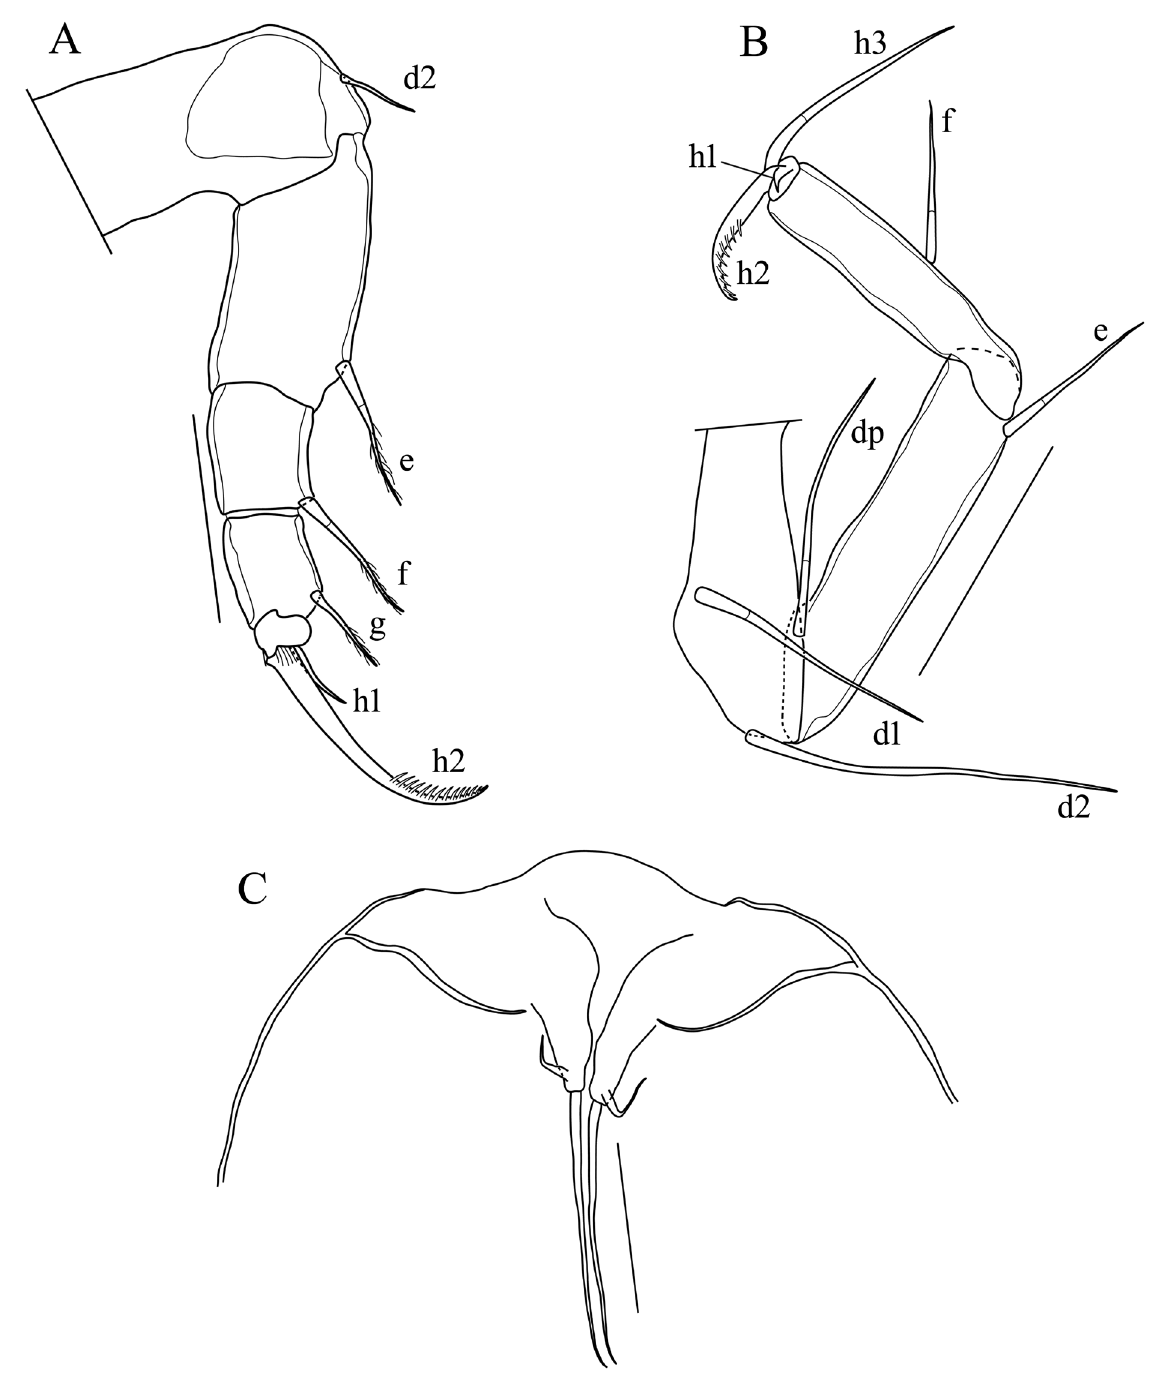
Fig. 10. Brasilodopsis baiabonita gen. et sp. nov. from Bonito, State of Mato Grosso do Sul, ♀. A . T2 (MZUSP 41832). B . T3 (MZUSP 41832). C . CR (MZUSP 41826). Abbreviations: see text and Material and methods. Scale bars: 50